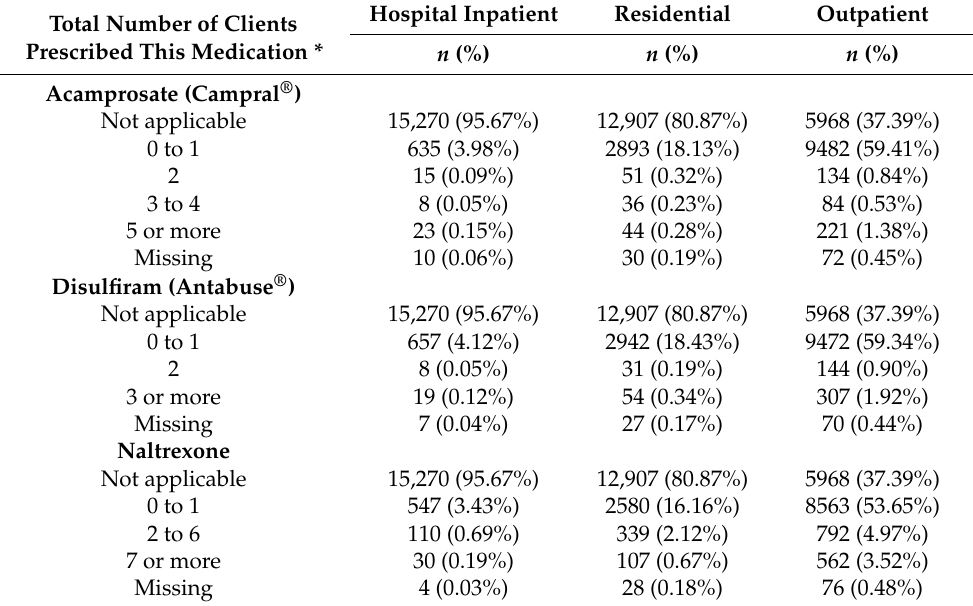
Table 2. Distribution of substance use disorder treatment facilities (hospital inpatient, residential, and outpatient) in 2019 by the total number of clients prescribed medication (acamprosate, disulfiram, and naltrexone) for alcohol use disorder using N-SSATS